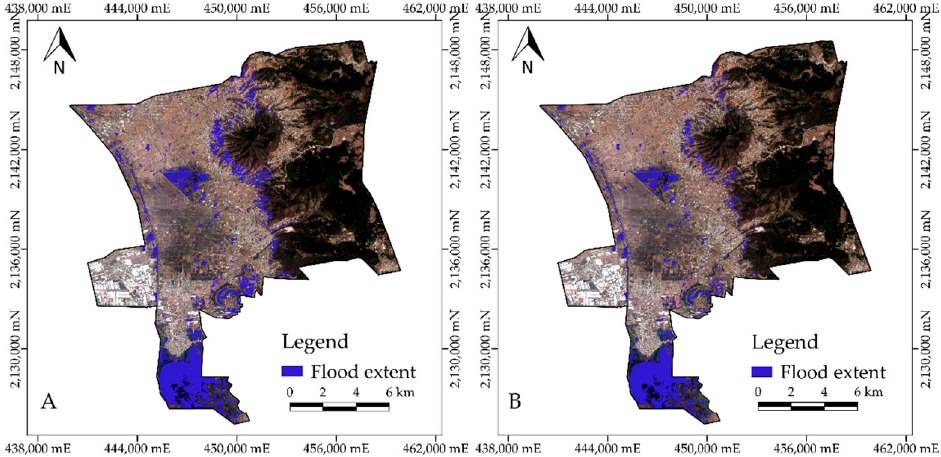
Figure 7. Extent of flooding in the rainy season with gradient boosting ( A ) and random forest ( B ) algorithms. Table 12. Area of water bodies in the dry season and flooding extent in the rainy season calculated by geospatial and temporal analysis of pixels (see Figures 6 and 7).